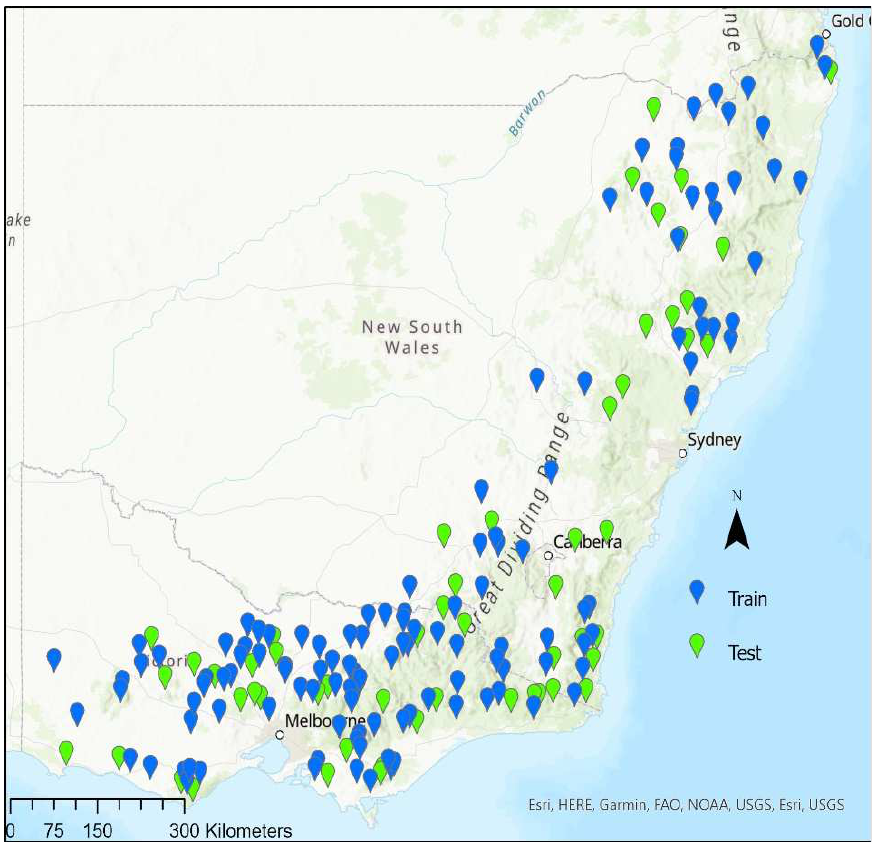
Figure 1. Location of the selected catchments. Table 1. Important statistics of the selected predictor variables for 181 study